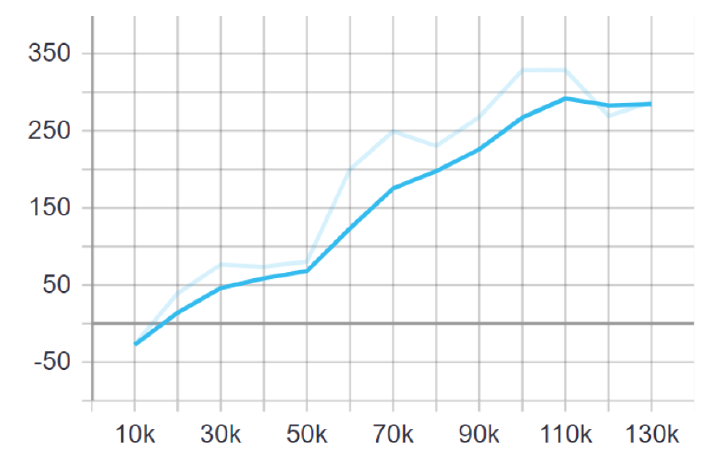
Figure 2. Cumulative reward of 1v1 training (Tensorboard).